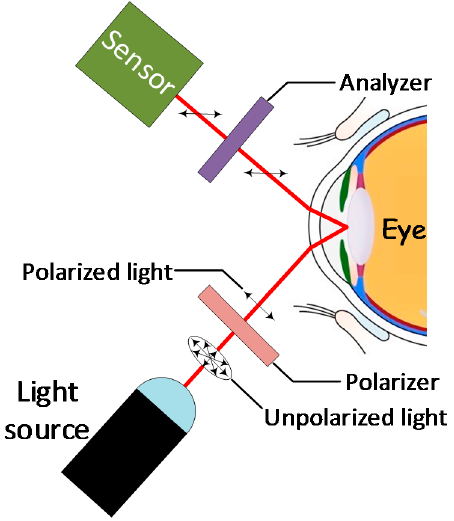
Figure 7. Principle of optical polarimetry in the eye for glucose monitoring. Table 7. Advantages and disadvantages of Optical Polarimetry.